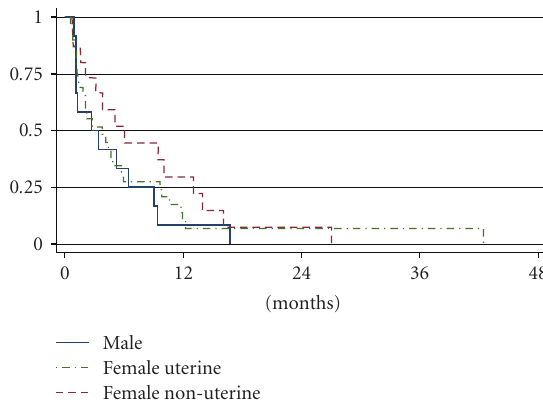
Figure 1: Progression free survival according to gender and site of origin.